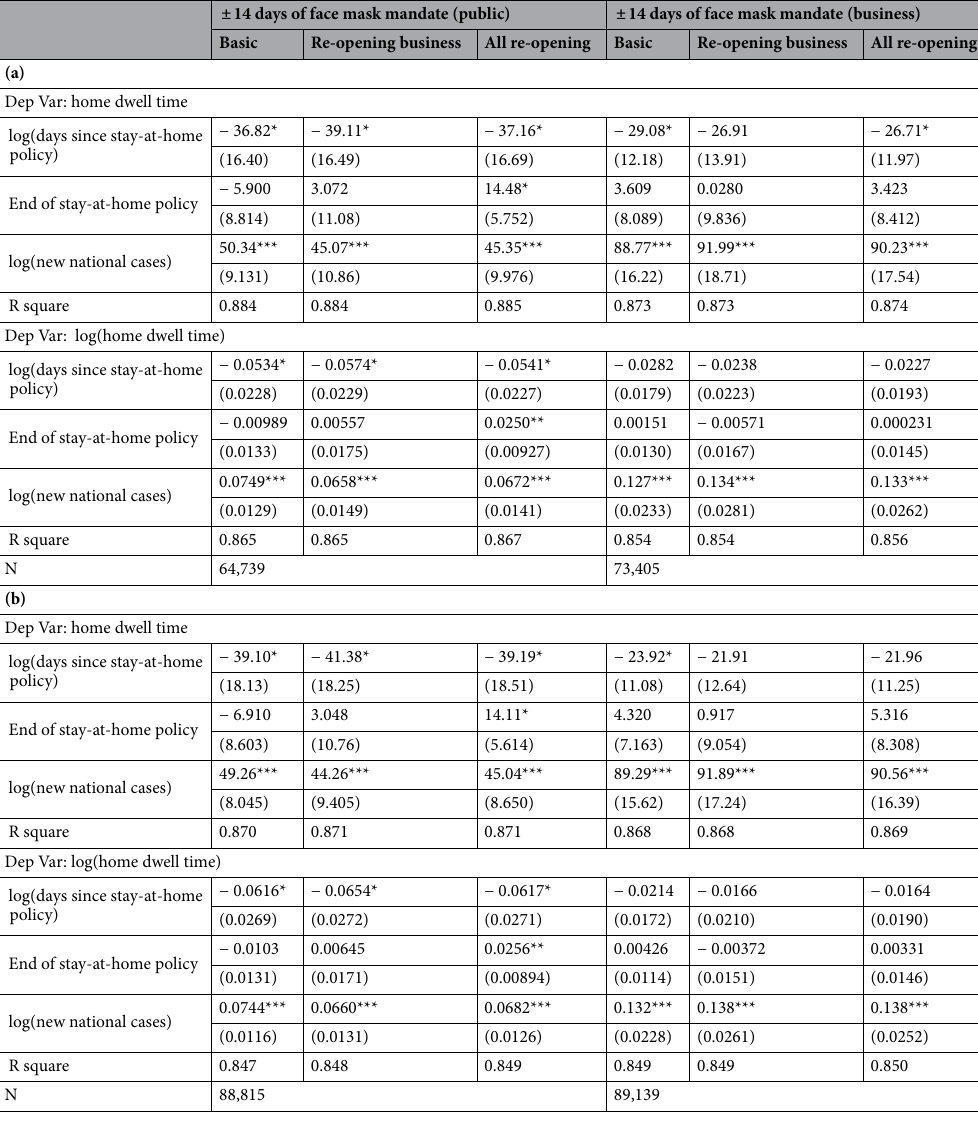
Table 1. Impacts of days since stay-at-home order issued on dwelling time at home (in min) during the mask mandate study periods for (a) with with-policy counties, and (b) all counties, with no-policy counties using